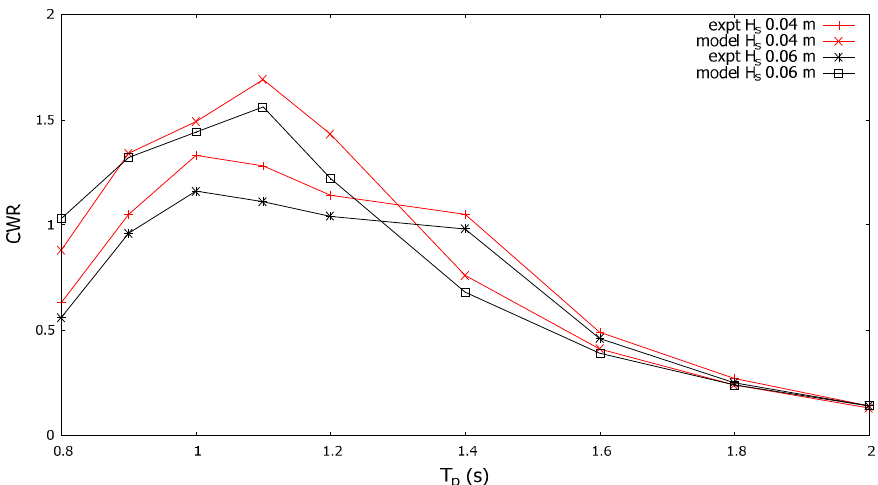
Figure 10. Variation of capture width ratio (CWR) with T p for H s ≈ 0.04 m and 0.06 m from experiment and linear di ff raction / radiation model with measured mean force.